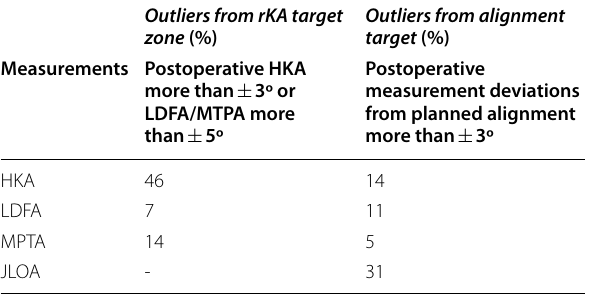
Table 2 Percentage of outliers from the rKA target zone and alignment target